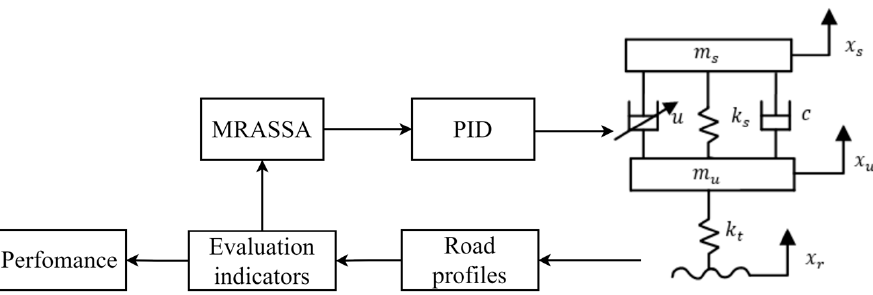
Figure 3. Suspension System framework.